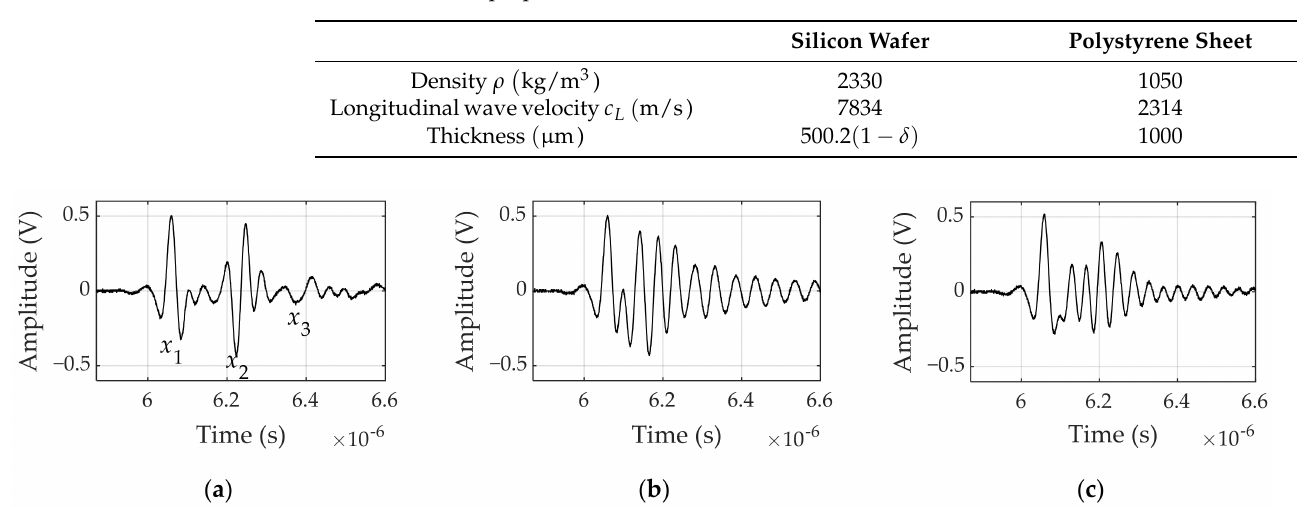
Table 2. Material properties.